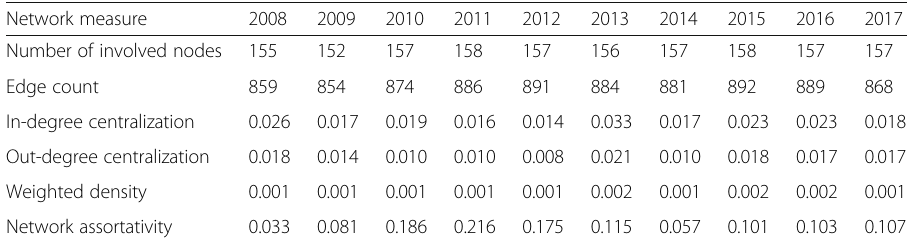
Table 4 Network statistics, 2008 – 2017 Network